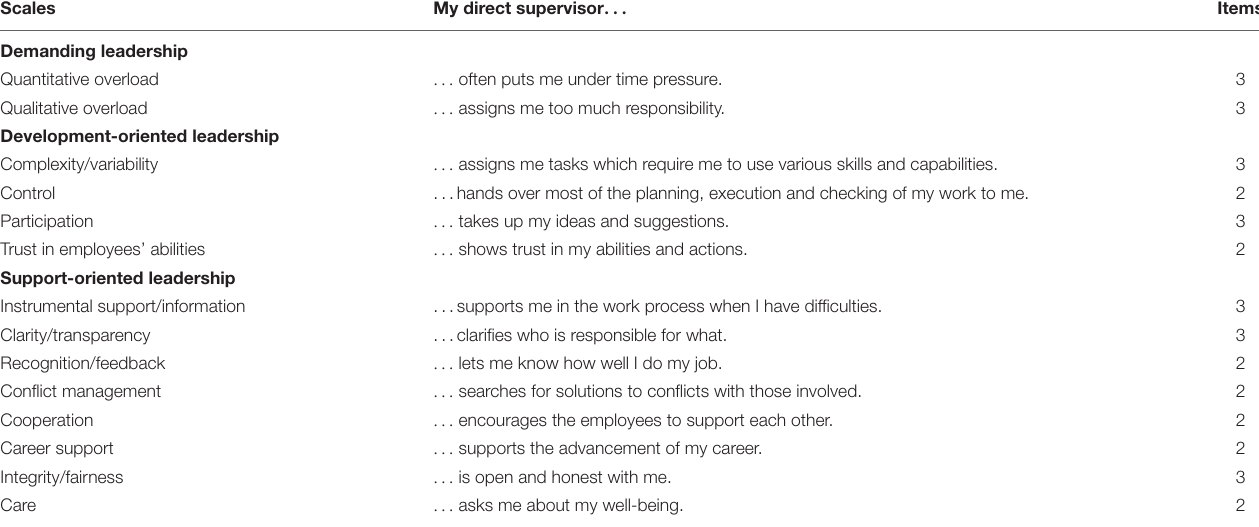
TABLE 1 | Scales of the HDLBQ with sample items. Scales My direct supervisor